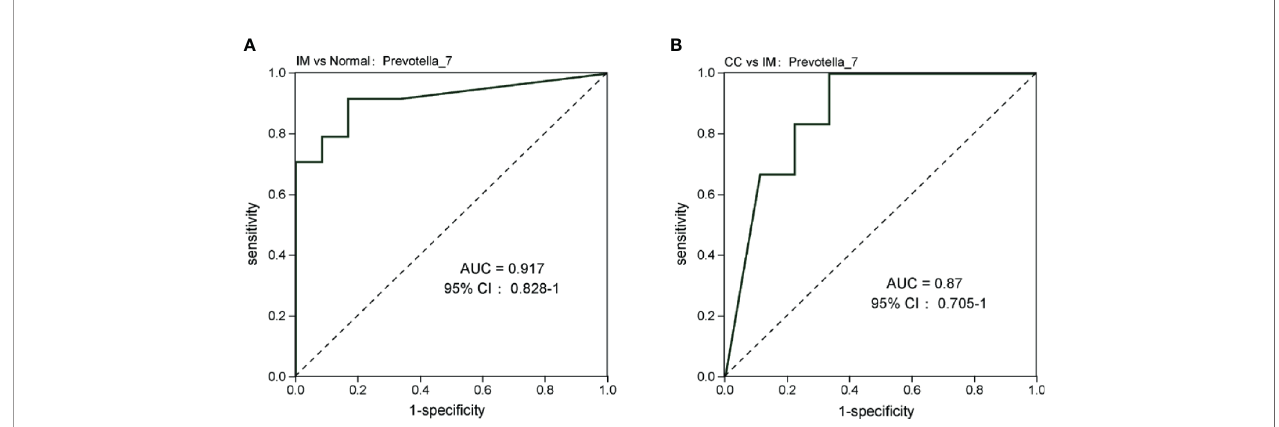
FIGURE 6 | Prevotella_7 is able to discriminate IM group from Normal group and CC group. (A) ROC curve analysis of IM group and Normal group. (B) ROC analysis of CC group and